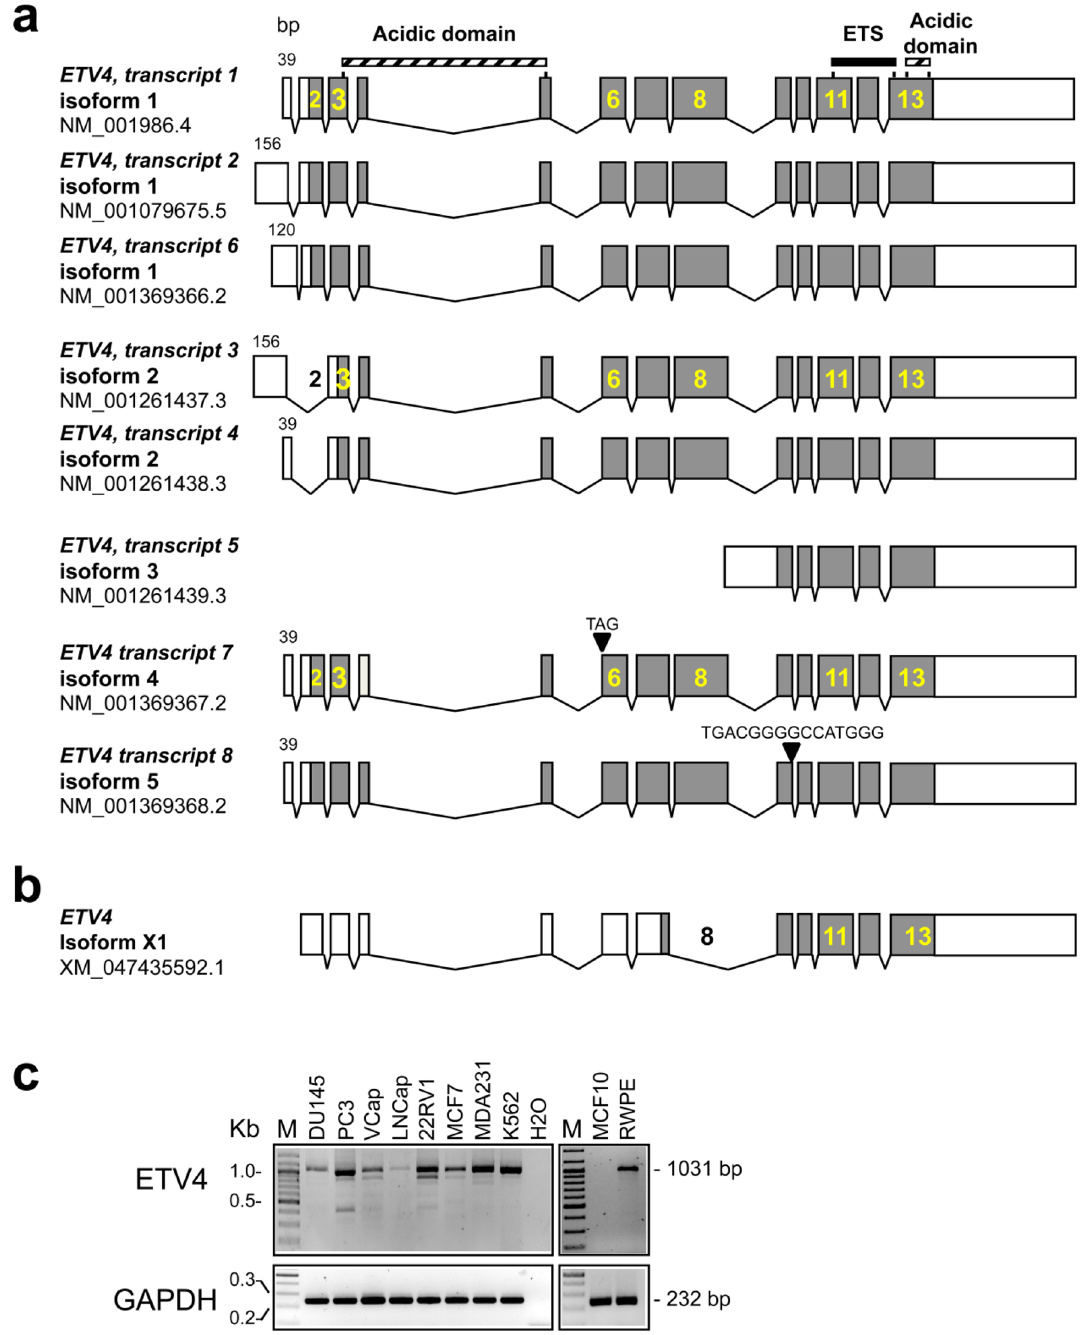
Figure 1. Schematic representation of the 9 transcripts of ETV4 gene reported in the NCBI RefSeq database (https:// www. ncbi. nlm. nih. gov/ gene) according to the ETV4 genomic sequence NC_000017.11 based on the GRCh38.p13 Primary Assembly. The identification numbers for each transcript and each protein isoform are reported. The position of functional features is shown on the top: DNA-binding ETS motif (black bar); Acidic domain (hatched bars). The exonic structure is shown with coding exon sequences in grey and the 5 ′ and 3 ′ UTR in white. The size (in bp) of the first exon of each transcript is reported. ( a ) Transcripts of ETV4 curated and listed in NCBI RefSeq database. Three transcripts encode for isoform #1, two transcripts encode for isoform #2, each one of the other 3 transcripts encodes for isoform #3, isoform #4 and isoform #5. Transcripts that encode for the same isoform show different 5’ UTR. Isoforms #4 and #5 differ to isoform #1 for the presence of a substitution (amino acid P instead of LA in isoform #4) or a deletion (DGAMG in isoform #5). Transcripts 7 and 8 differ from transcript 1 for some small nucleotide deletions. ( b ) Structure of the hypothetical transcript XM_047435592.1 that should encode for an isoform (X1) of 221 amino acids (24 kDa) due to a start codon in exon 7 restoring the reading frame in spite of a frameshift from skipping of exon 8. ( c ) ETV4 transcripts assessed in several human cancer (prostate: DU145, PC3, VCap, LNCap, 22RV1; breast: MDA-MB-231 indicated as MDA231, MCF7; leukemia: K562), and normal (prostate RWPE and breast MCF10) cell lines by RT-PCR. The primers, in exon 3 and 12, used to amplify the retro-transcribed ETV4 cDNA are reported in Supplementary Table. GAPDH was used as amplification control. H20: reagent control; M: 100 bp ladder. The sizes of the expected bands are reported on the